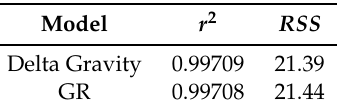
Table 1. Statistical parameters.